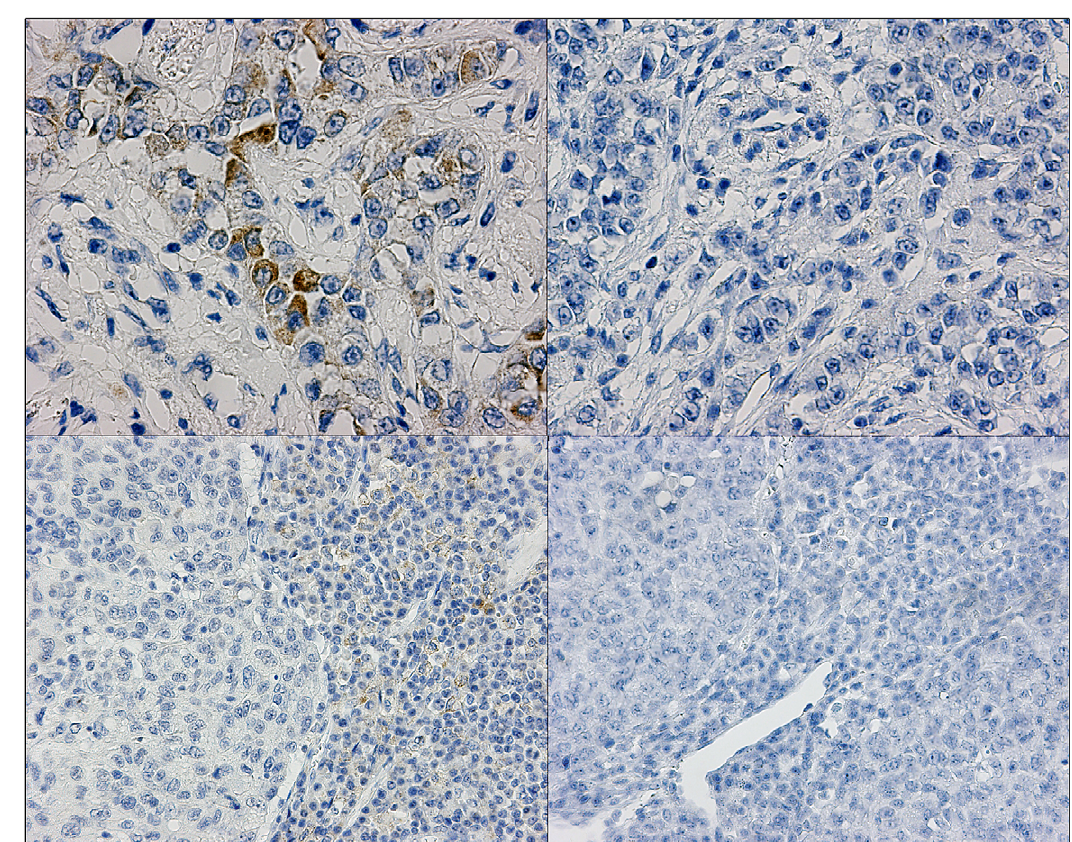
Fig. 1. HER2 immunohistochemistry (IHC) by the Oracle HER2 Bond IHC detection system and HercepTest. Top left: Oracle shows cytoplasmic staining while HercepTest does not for the same tumor (top right). Bottom left: Oracle shows a specific staining of the surrounding inflammatory cells while HercepTest (bottom right) does not. (The colors are visible in the online version of the article.)